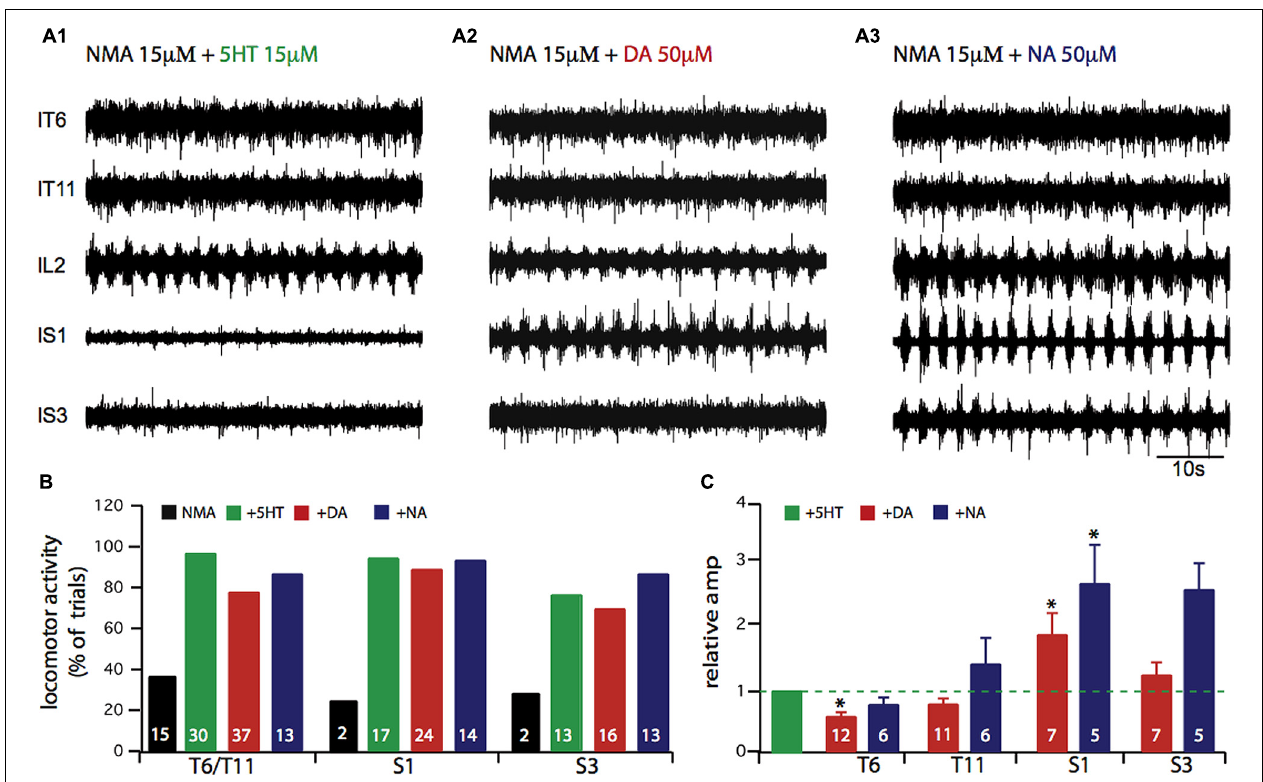
FIGURE 2 | Comparison of axial locomotor network activation in vitro by 5-HT, or DA or NA. (A) Each amine was added to 15 μ M NMA-containing saline during recordings from the sixth and eleventh left thoracic ventral roots (lT6, lT11), the second left lumbar ventral root (lL2), and the first and third left sacral ventral roots (lS1, lS3). (B) Plots indicating the percentage of